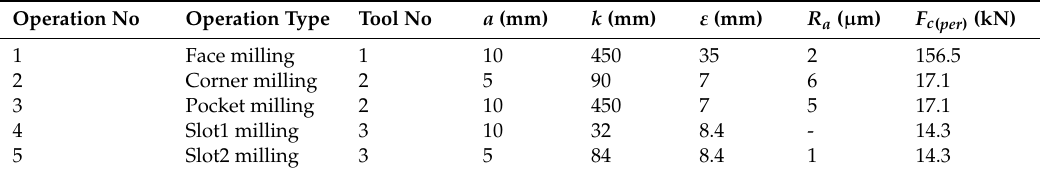
Table 3. Required machining operation for case study [14].